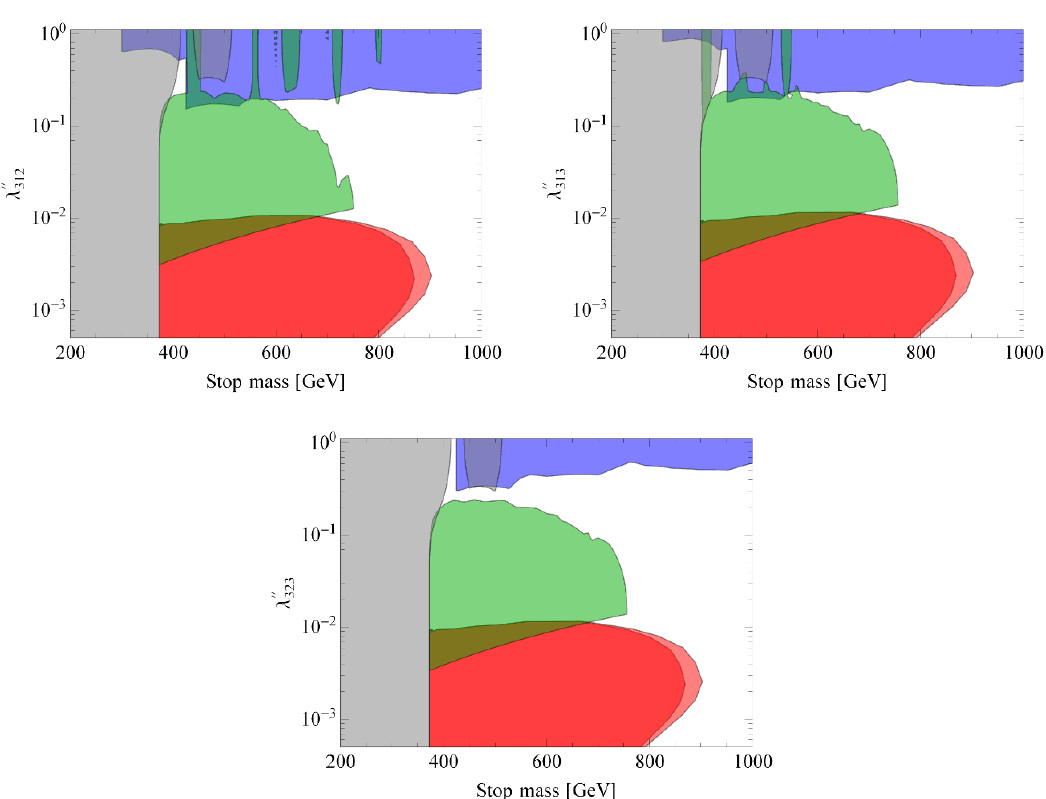
Figure 10. Exclusion plots for a 200 GeV bino neutralino LSP with the U(1) R symmetry strictly . 375 GeV) is excluded by paired dijet preserved. The grey region on the left side of the plots ( m ~ t searches. Next, consider the middle region of the plots. Starting from large (cid:21) 00 couplings and 3 ij working downwards, the blue region is excluded by dijet searches, the green region is excluded by neutralino LSP searches and the red regions are excluded by displaced vertices searches. Bino pair production, which contributes to the displaced vertices limits, depends on the masses of the (cid:12)rst and second generations of squarks. Setting the masses of these squarks to 10 TeV results in the darker red region being excluded. Instead, setting the masses of these squarks to 1 TeV excludes both the darker red and lighter red